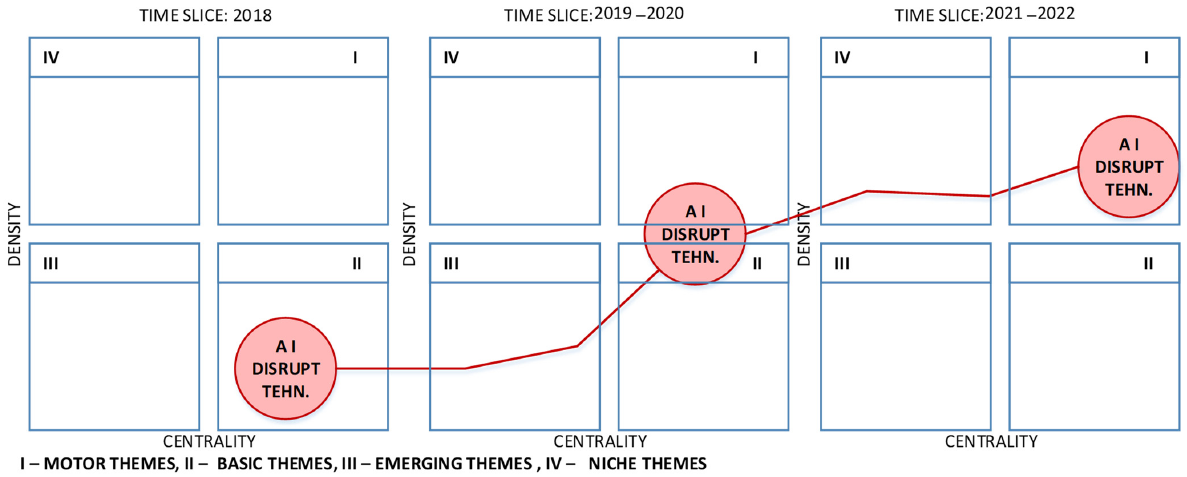
Figure 9. Topic evolution across the 3 time slices analysis of thematic evolution (n =